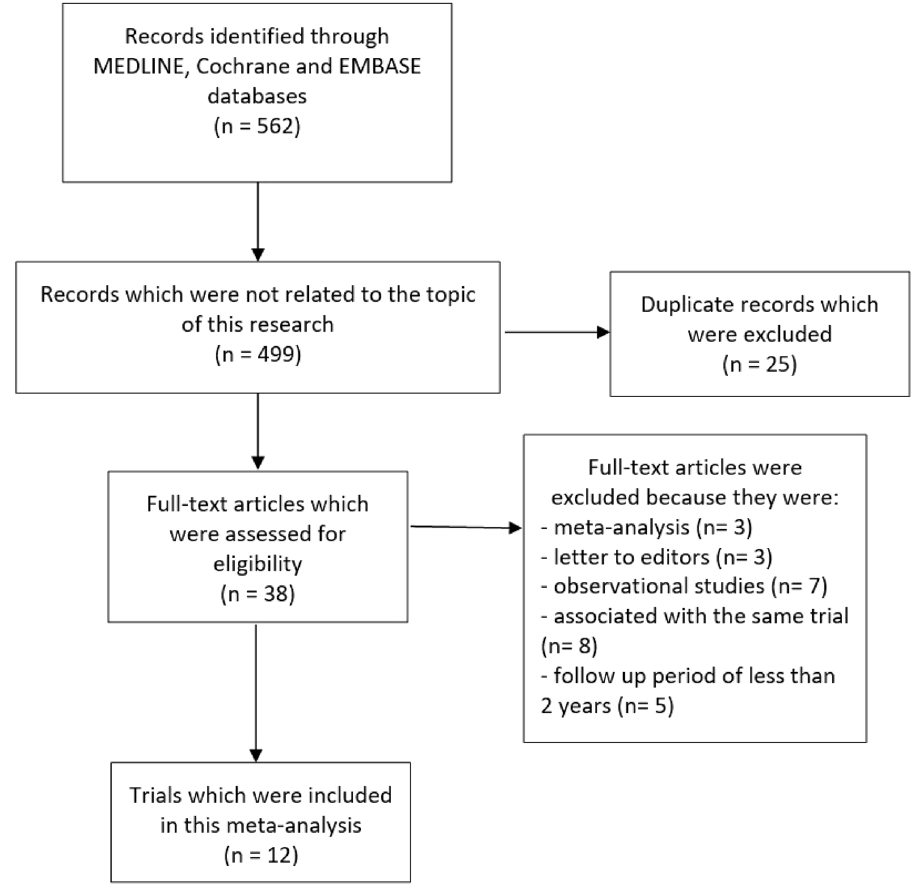
Figure 1. Flow diagram representing the study